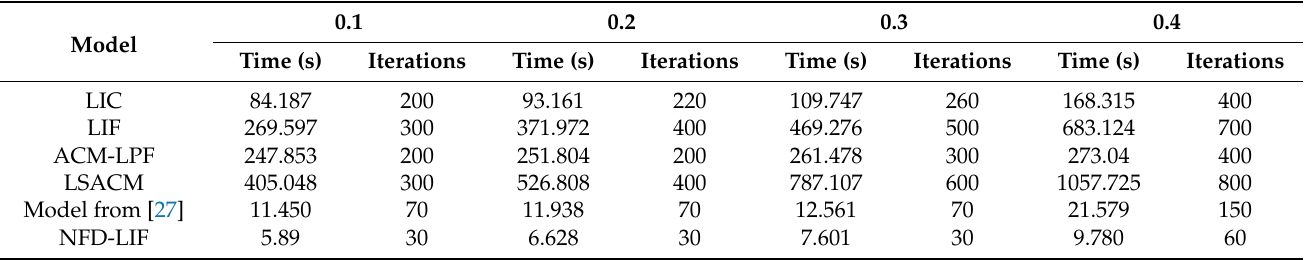
Table 4. Comparison of Model Segmentation Running Times and Number of Iterations for Different Pretzel Noise Levels on Texture Information-Rich Images.